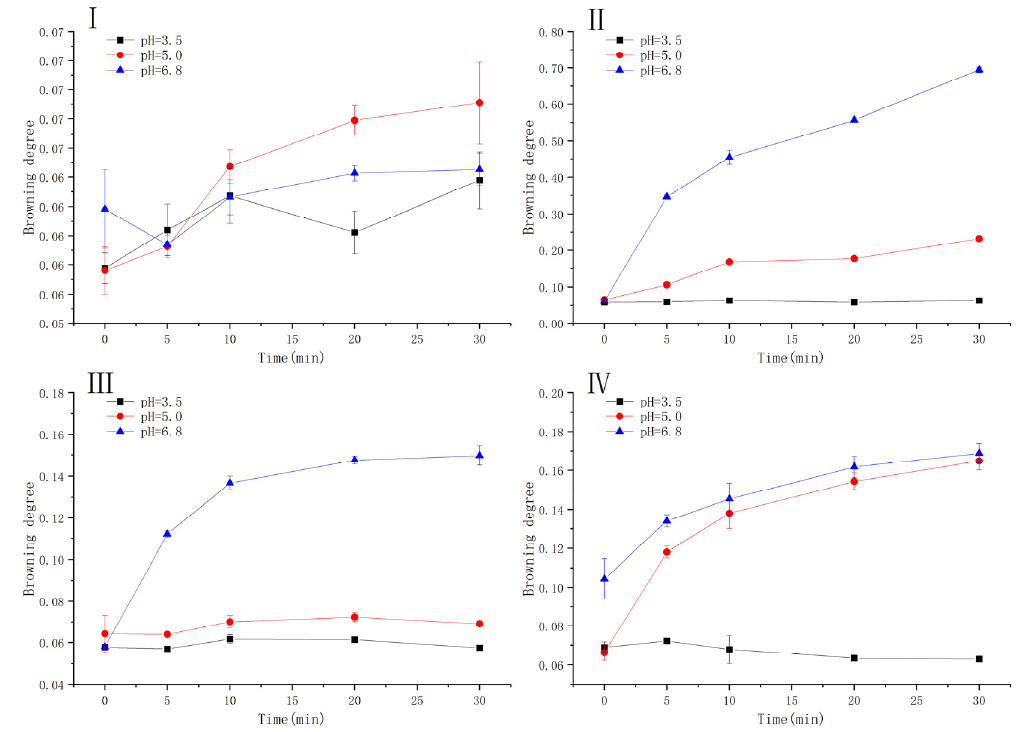
Figure 3. The browning degree of enzymatic browning products of ( I ) Catechin ( II ) Epicatechin ( III ) Caffeic acid ( IV ) Chlorogenic acid in various pH values.